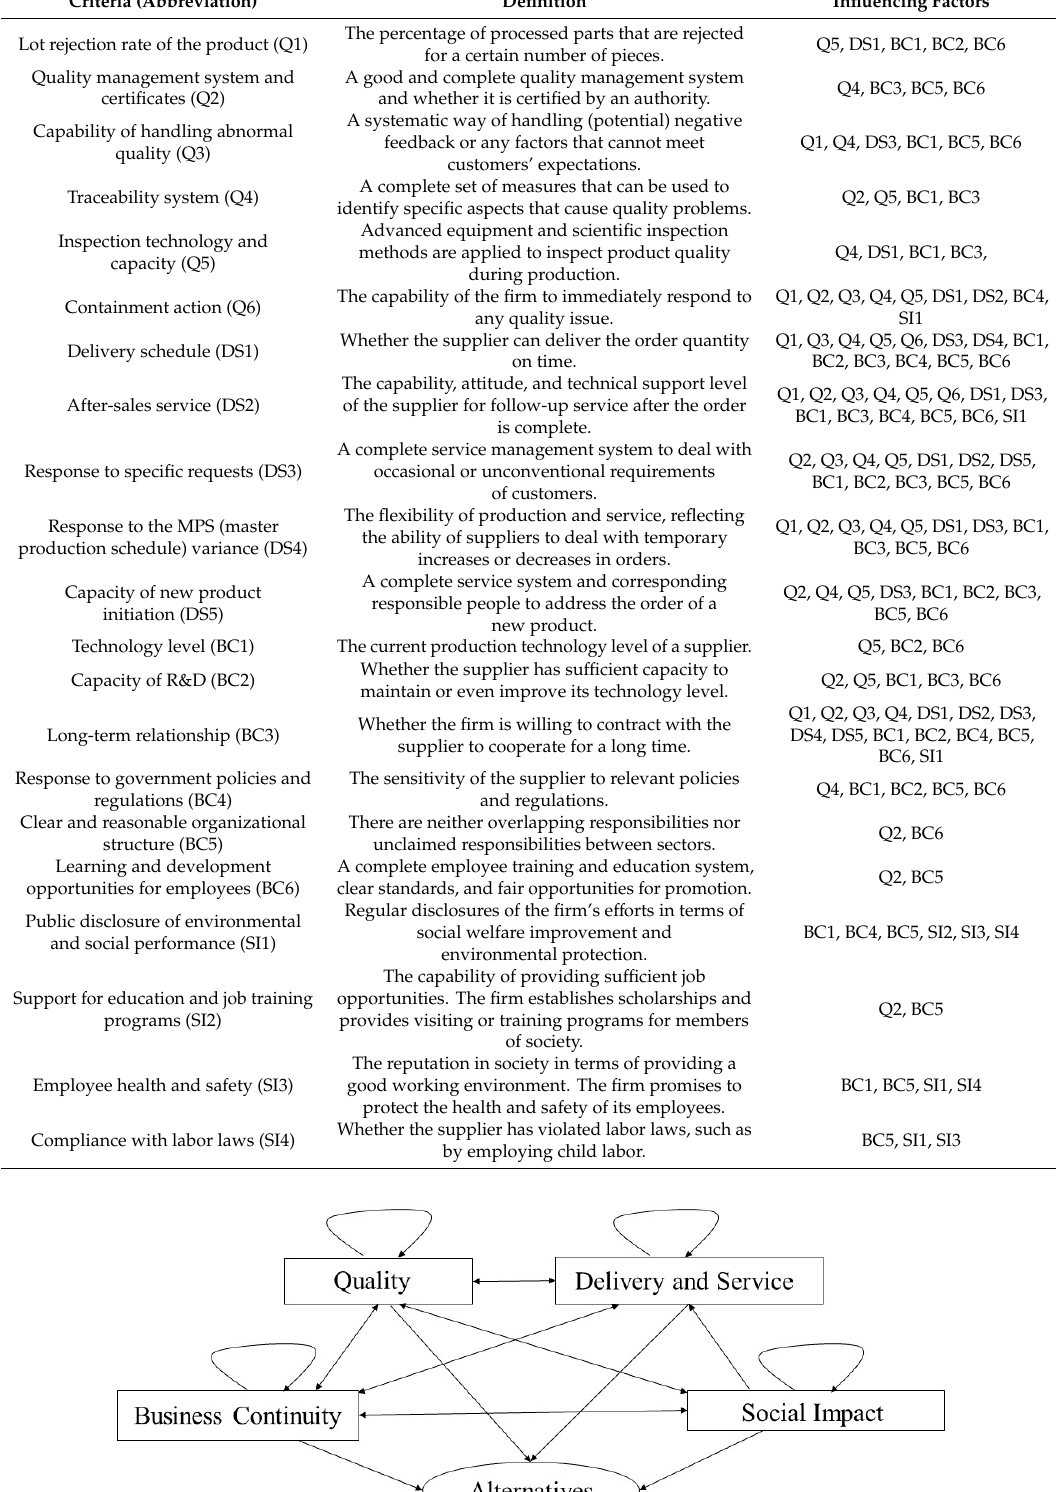
Table 1. The multiple criteria framework used to evaluate the suppliers’ soft competitiveness.